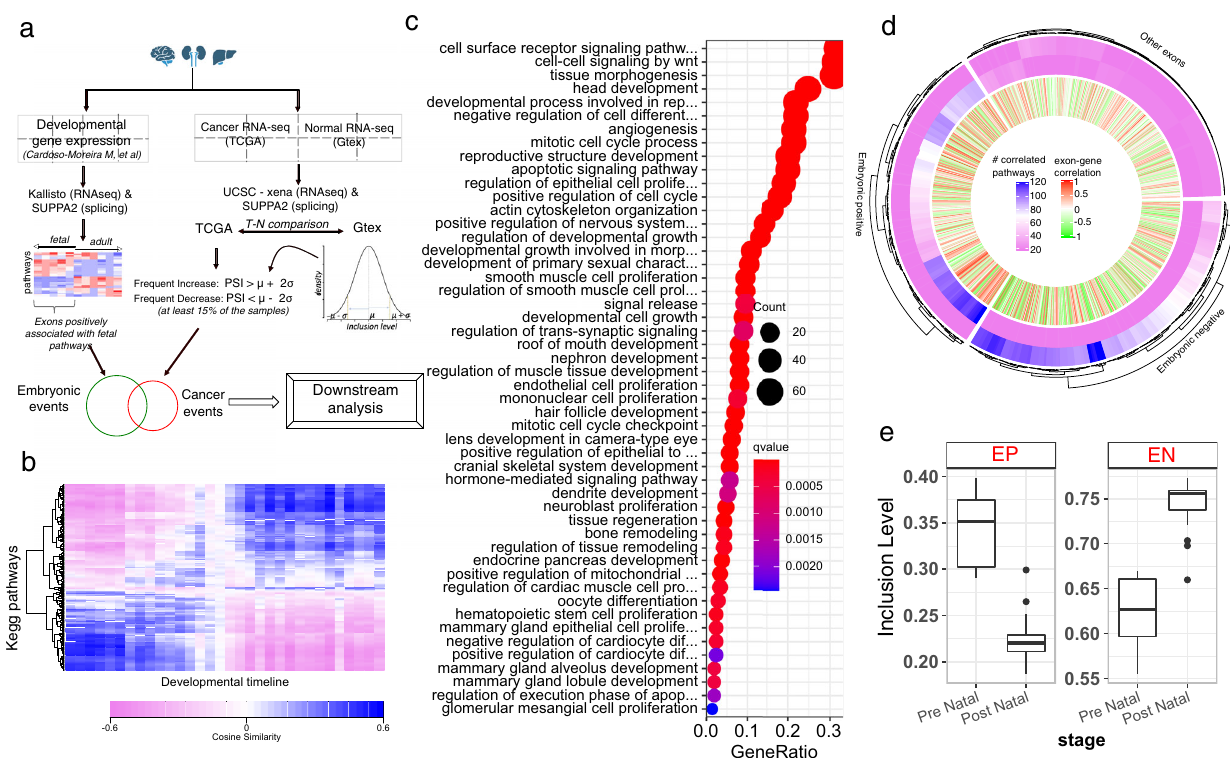
Fig.1|DetectionofASeventsrelevanttodevelopmentoforgans.a Overviewof the pipeline for the identi fi cation and comparison of developmental and cancer- associated splicing events. b Hierarchical clustering of KEGG pathways in brain cerebellum. Each colored cell in the heatmap corresponding to a pathway p and a developmental time point t represents the cosine similarity between p ’ s contribu- tion(loading)tothe fi rst5PCsandt ’ sPCscoreforthe fi rst5PCs,thusindicatingthe activity of pathway p at timepoint t ( “ Methods ” ). c Dot plot for the GO term enrichment of the genes comprising embryonic pathways inferred in ( b ). Dots are coloredbasedonFDR-correctedone-sided p -valuefromFisher ’ stest(labelledasq- value) as implemented in clusterPro fi ler package in R and sized based on the number of genes in each functional category. d Circular heatmap showing the number of positively and negatively correlated embryonic pathways with each exon. Each leaf in the dendrogram is an exon. Outer two rows represent respec- tively the number (per legend colors) of positively and negatively correlated